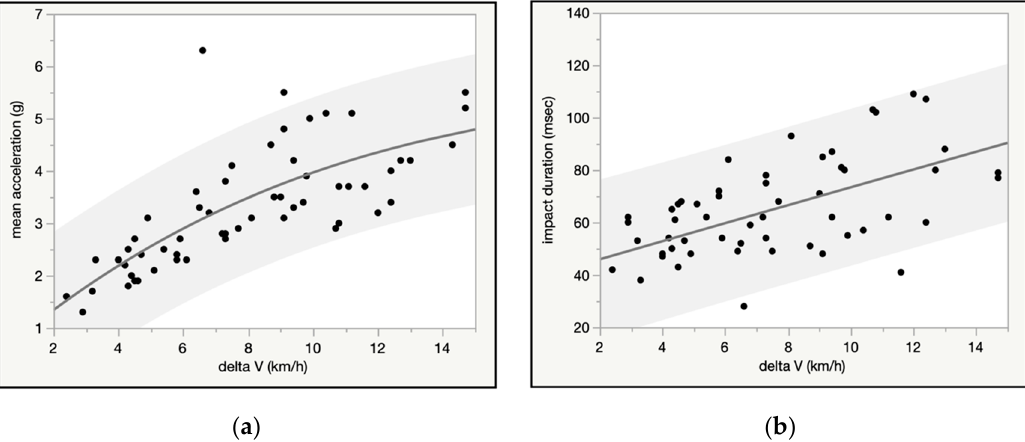
Figure 7. ( a ) Impact duration (msec) vs. delta V (km/h) for 94 real world crashes. ( b ) mean acceleration (g) vs. delta V (km/h) for 114 real world crashes.